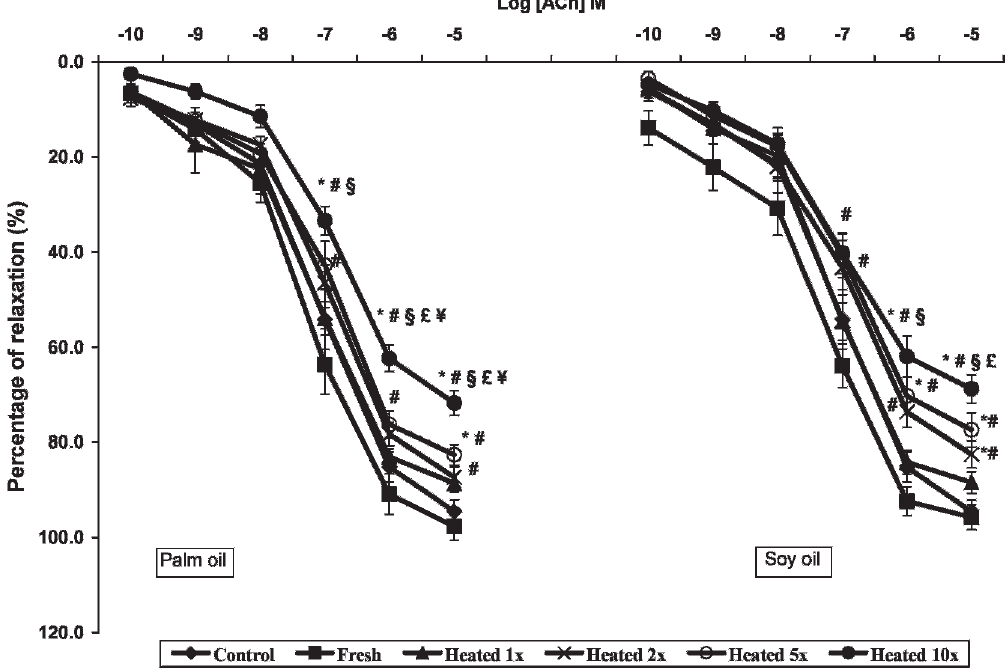
Figure 3 - Endothelium-dependent relaxation induced by acetylcholine (ACh) in aortic rings that were isolated from rats that were fed for 24 weeks with a basal diet (control), fresh palm or soy oil, or palm or soy oil that was heated once (1x), twice (2x), five times (5x) or ten times (10x). The results are the means ¡ SEM (n=10) . Significant difference ( p , 0.05) versus the * control, # fresh-oil group, 1 1x heated-oil group, £ 2x heated-oil group, or ¥ 5x heated-oil group. Dose response curves are plotted as percentage of relaxation against the maximal phenylephrine (PE, 10 2 6